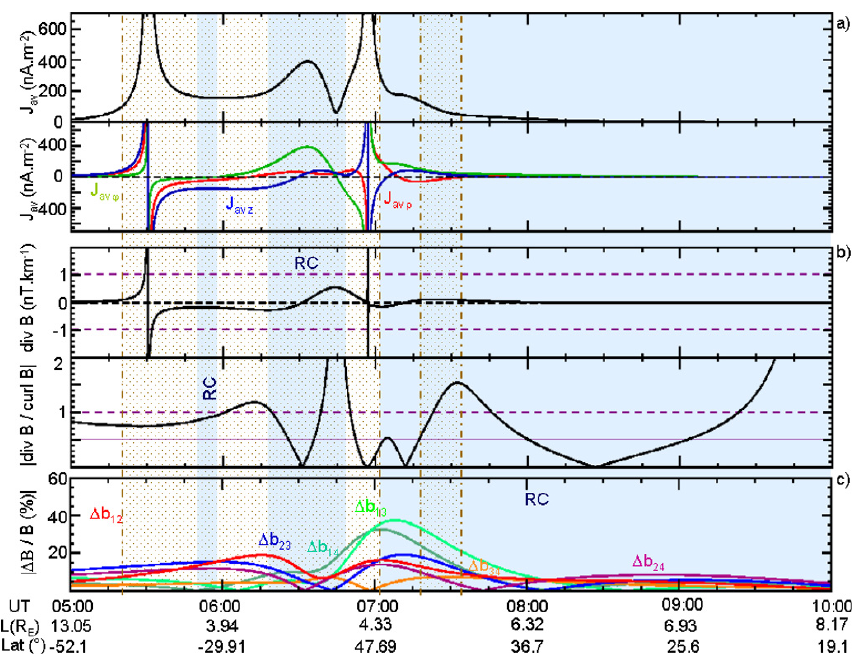
Fig. 7. Same as Fig. 6, but using a Tsyganenko